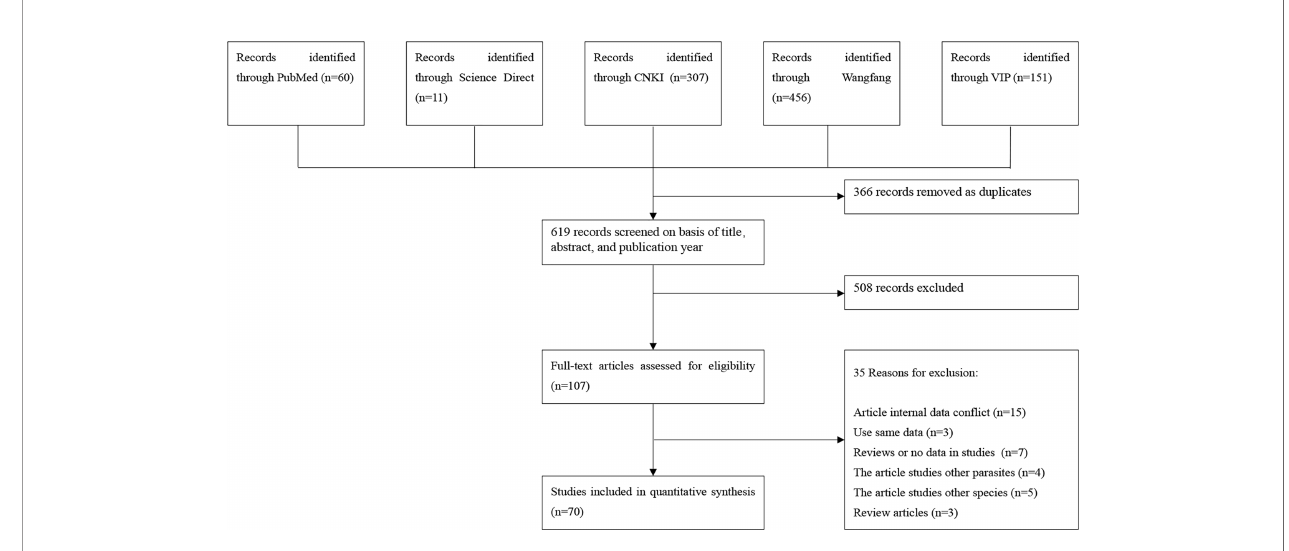
FIGURE 1 | Flow diagram of eligible studies for searching and